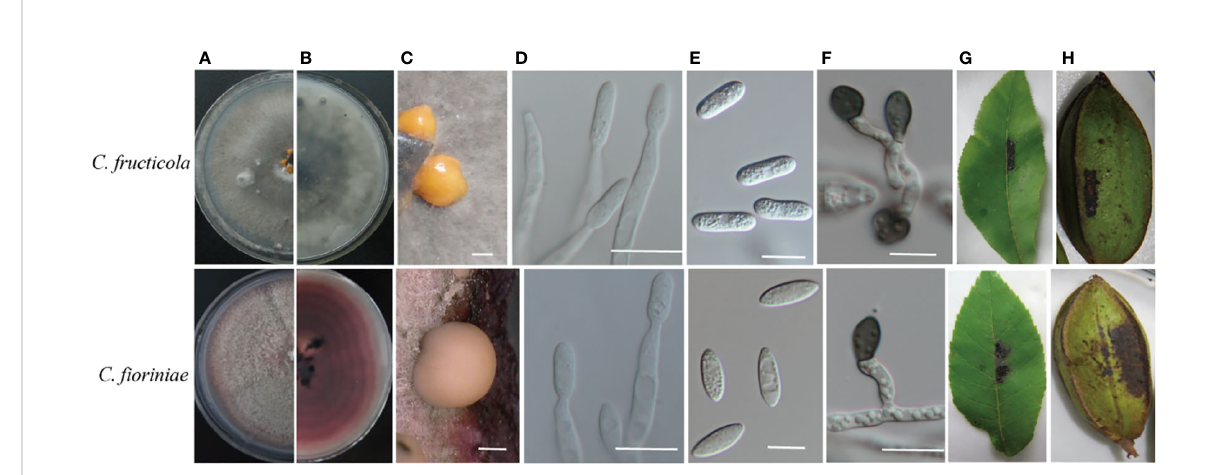
FIGURE 3 Cultural characteristics and pathogenicity of two Colletotrichum species isolated from the pecan tree. (A, B) front and back views of 14-days- old PDA culture; (C) conidiomata ; (D) conidiophores; (E) conidia; (F) appressoria. The symptoms were caused by (G, H) appearing on the leaves 6 days after inoculation and on the shuck of the fruit 20 days after inoculation with conidia. (C, E, F) : Bar = 10 µm. (D) : Bar = 50 µm.